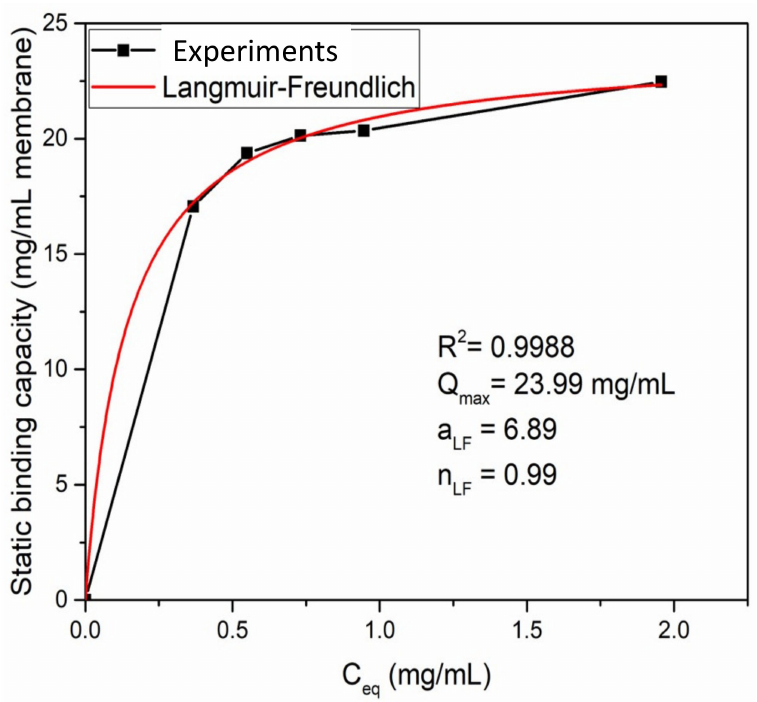
Figure 8. Langmuir–Freundlich curve for ATRP of a 6 h PVCL modified membrane. Table 1. The effect of grafting degree on dynamic binding capacity (DBC) and recovery of bovine serum albumin (BSA) at two protein loading